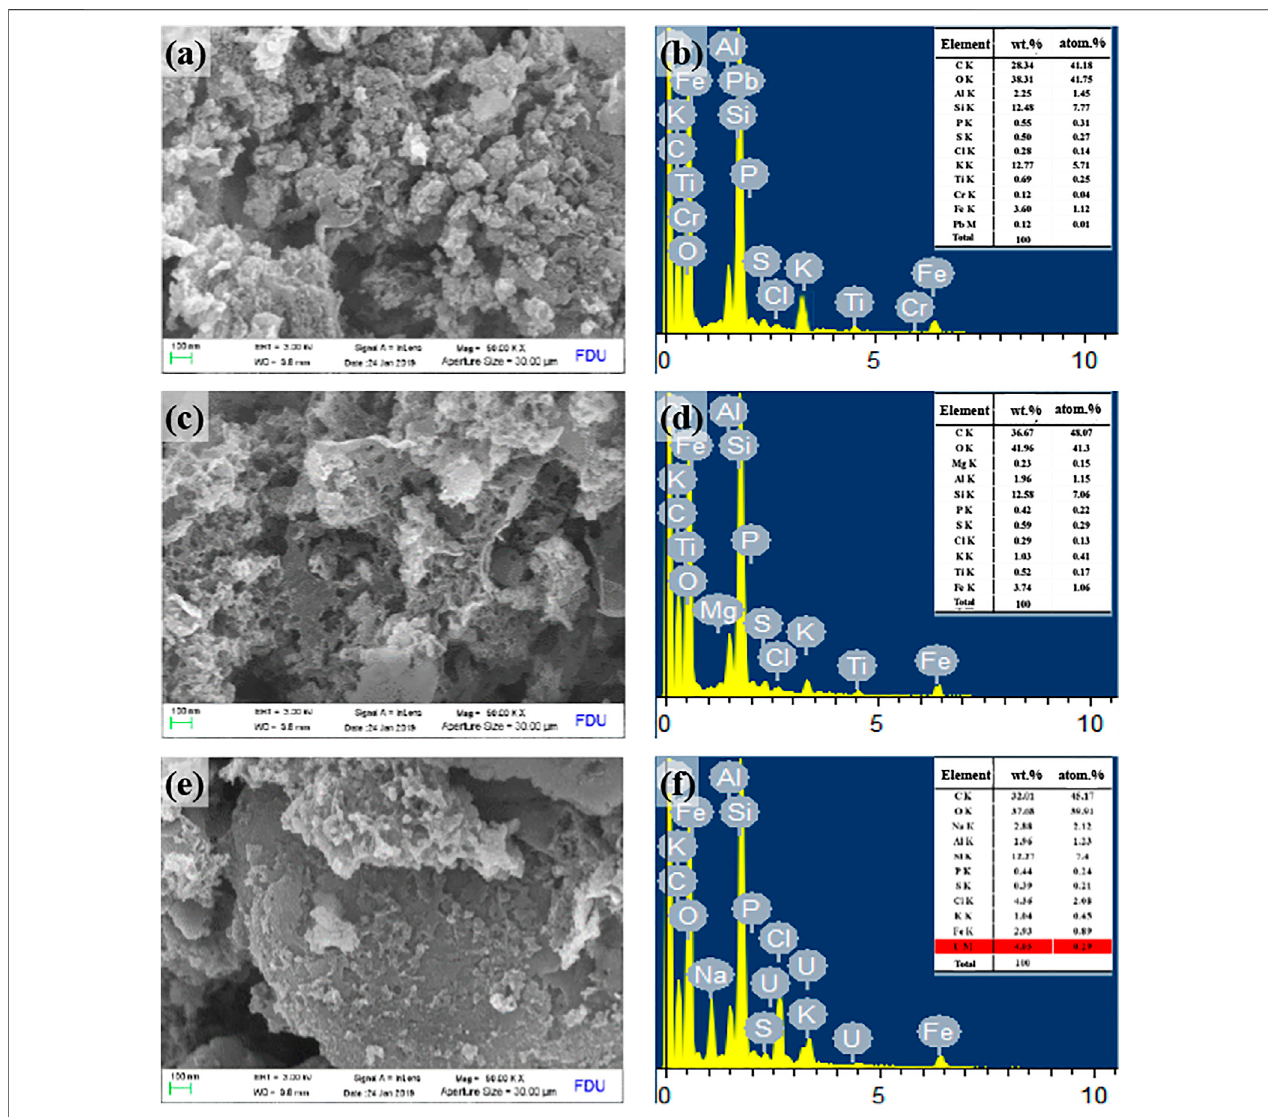
FIGURE 5 | Scanning electron microscope (SEM) and energy-dispersive x-ray spectroscopy (EDS) characterization results of SBB, ASBB, and ASBB-U, (A) SEM of SBB ’ surface, (B) EDS of SBB ’ surface, (C) SEM of ASBB ’ surface, (D) EDS of ASBB ’ surface, (E) SEM of ASBB-U ’ surface, (F) EDS of ASBB-U ’ surface.